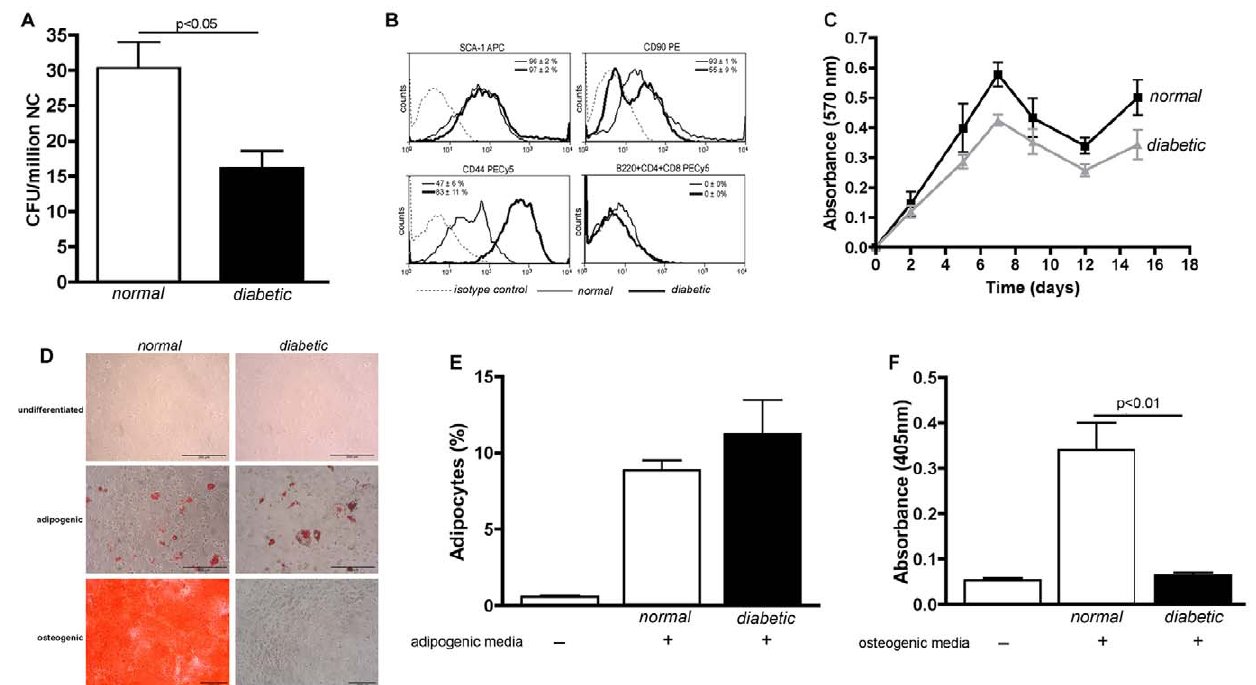
Figure 5. MSCs isolated from diabetic mice are exhausted. MSCs obtained from age-matched healthy mice ( normal ) or from mice 90 days after diabetes induction ( diabetic ) were characterized. Abundance in bone marrow was determined by CFU assay (A). Immunophenotyping was assessed by flow cytometry analysis after immunostaining with monoclonal antibodies against B220, CD4, CD8, SCA-1, CD90 and CD44 (B). Proliferation kinetic was evaluated according to crystal violet staining (Absorbance, 570 nm) during 15 days (C). Differentiation potentials were assessed after in vitro exposure to adipogenic or osteogenic medium and staining with Oil Red or Alizarin Red, respectively (D). Adipocytes generated were stained with Nile Red and quantified by flow cytometry (E). Matrix mineralization was quantified spectrophotometrically (Absorbance, 405 nm) after Alizarin Red staining (F). Qualitative data are representative from 4 animals per experimental group. Quantitative data correspond to mean 6 s.e.m. from 4 animals per experimental group. Only statistical significant values are